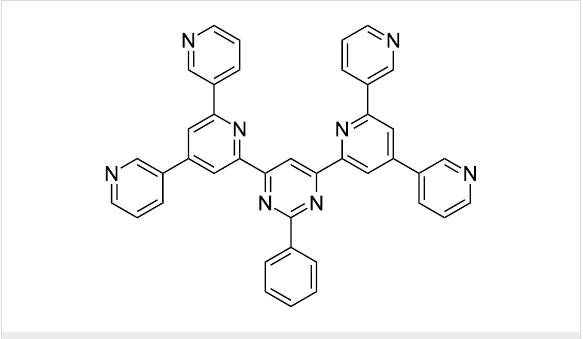
Figure 1: Structure of the 3,3 ′ -BTP